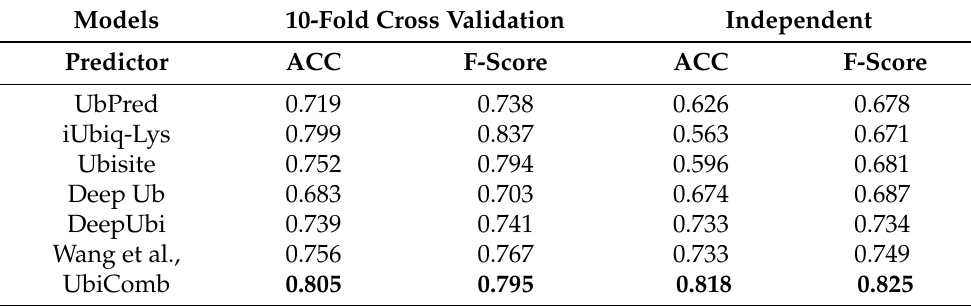
Table 5. Independent dataset comparison of UbiComb with existing predictors.